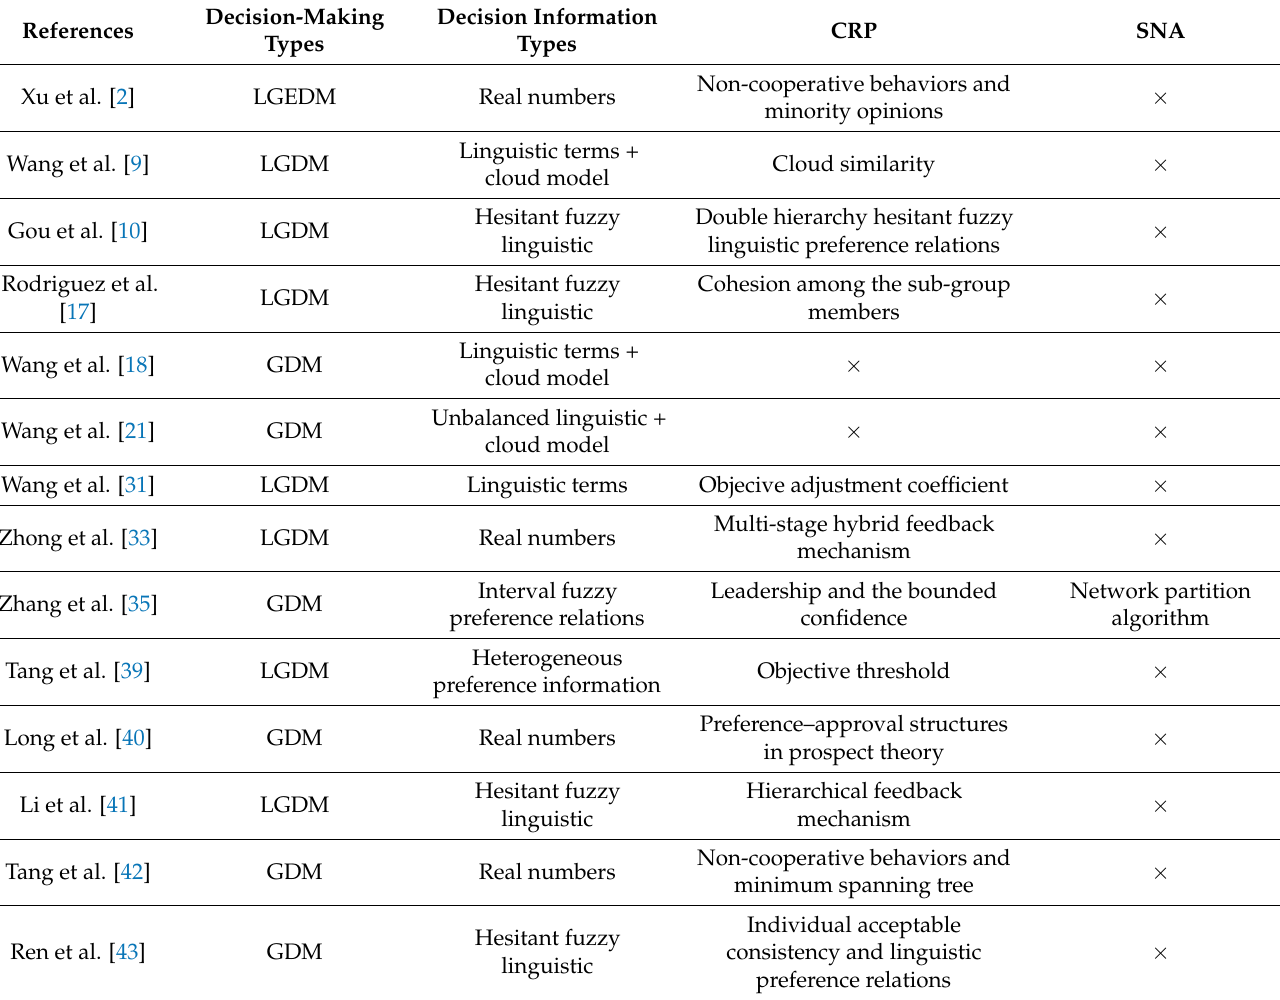
Table 1. The comparison of the related